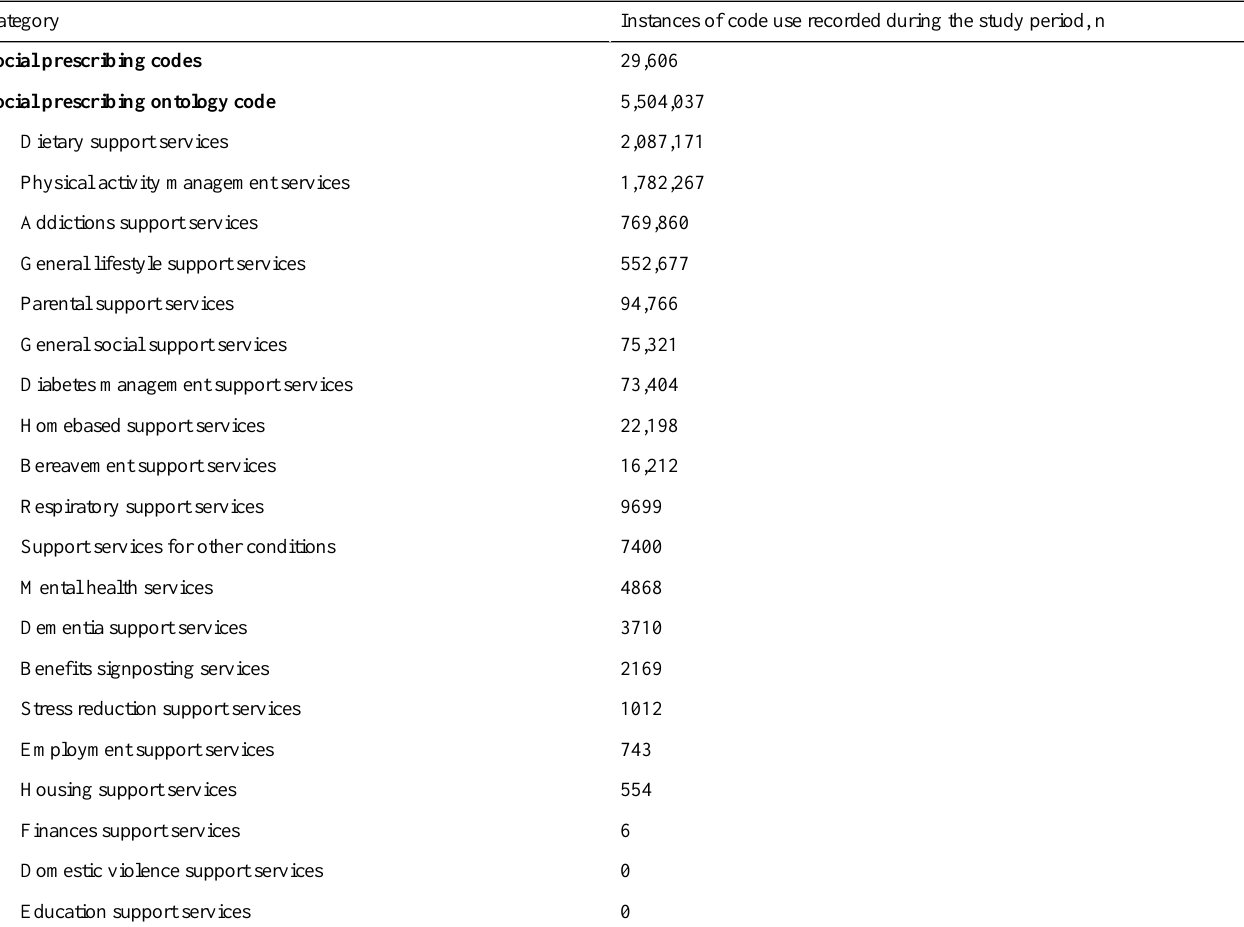
Table 2. Number of instances of use of social prescribing and social prescribing ontology codes within the Royal College of General Practitioners Research Surveillance Centre from January 01, 2011, to Dec 31, 2019 (N=5,533,643). Instances of code use recorded during the study period,